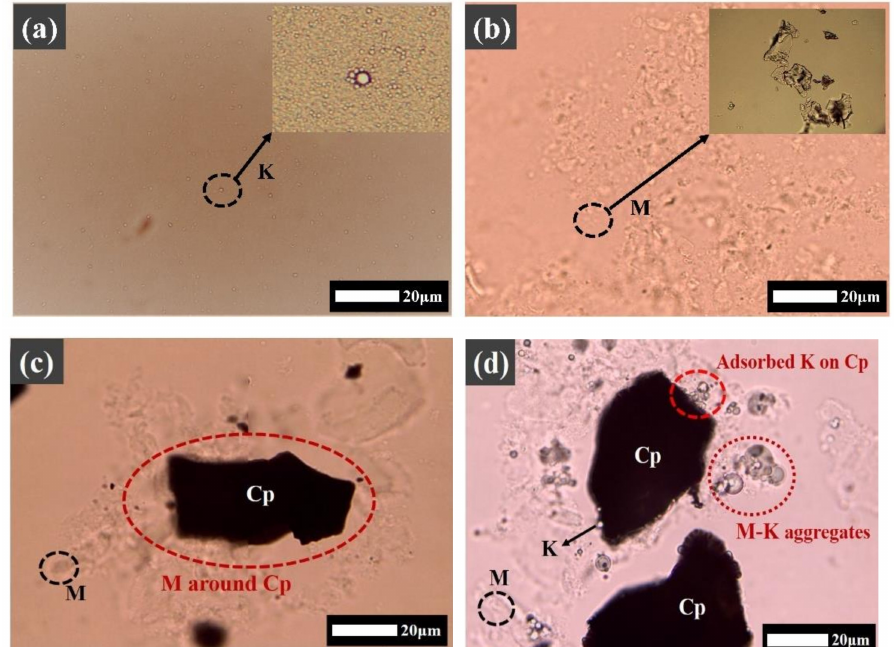
Figure 4. Optical images of: ( a ) kerosene emulsion; ( b ) precipitates in 0.05 M MgCl 2 ; ( c ) chalcopyrite in 0.05 M MgCl 2 ; ( d ) chalcopyrite + kerosene in 0.05 M MgCl 2 . All solutions were controlled at pH